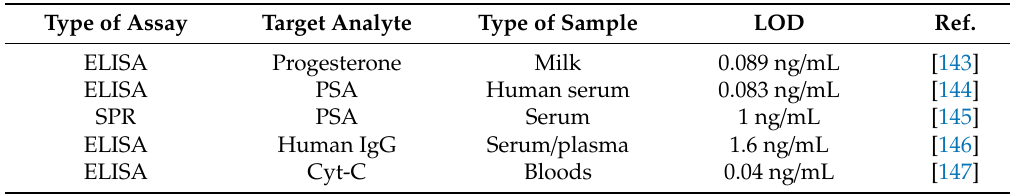
Table 4. Examples of commercial